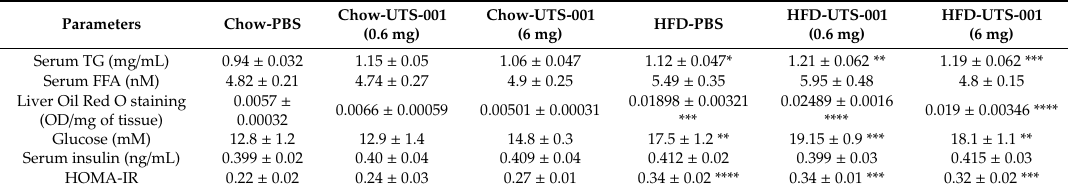
Table 2. Lipid and glucose profiles in mice with HFD and UTS-001